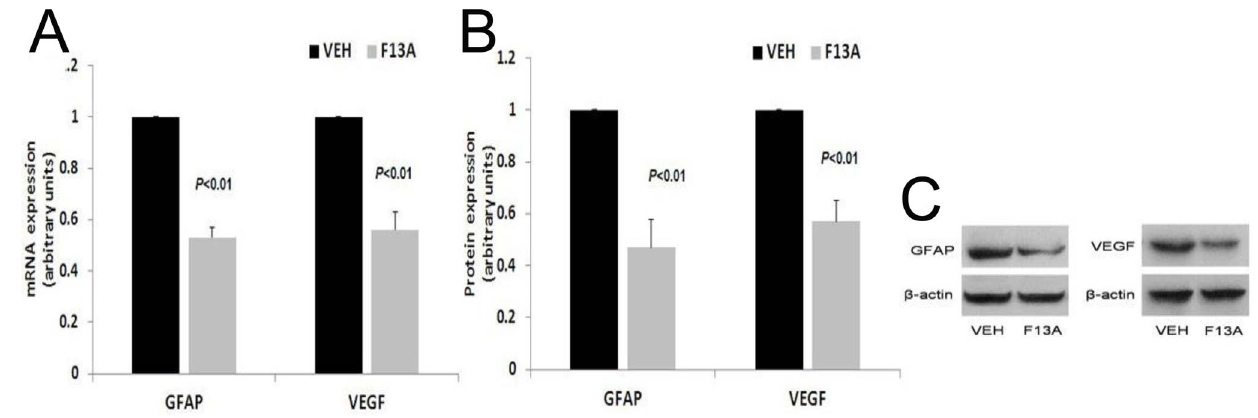
Figure 4. The effect of F13A on VEGF and GFAP mRNA (A) and protein (B) levels in the retinas of diabetic rats were analyzed using RT-PCR and Western blot in vehicle-treated diabetic rats (VEH) and F13A-treated diabetic rats (F13A). Representative Western blots are shown (C).